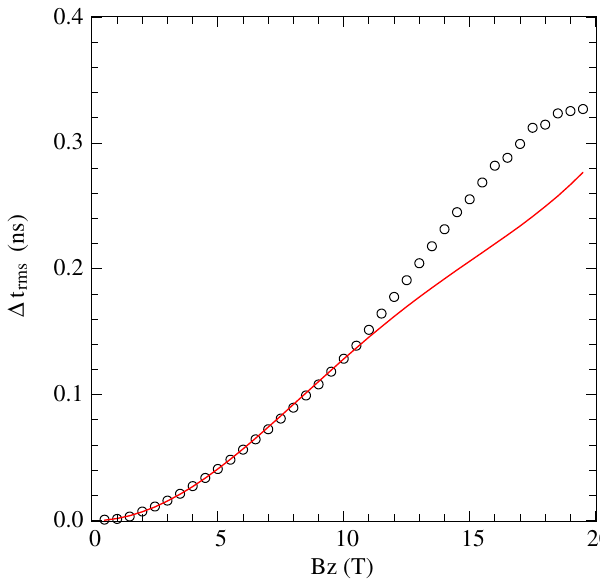
FIG. 4. Comparison of the simulated (circles) and analytic calculation (red curve) of (cid:1) t rms for a beam with finite extent and an axial velocity tilt. The calculation of (cid:1) t rms does not take into account the tilt. The solenoid is the case that is mostly